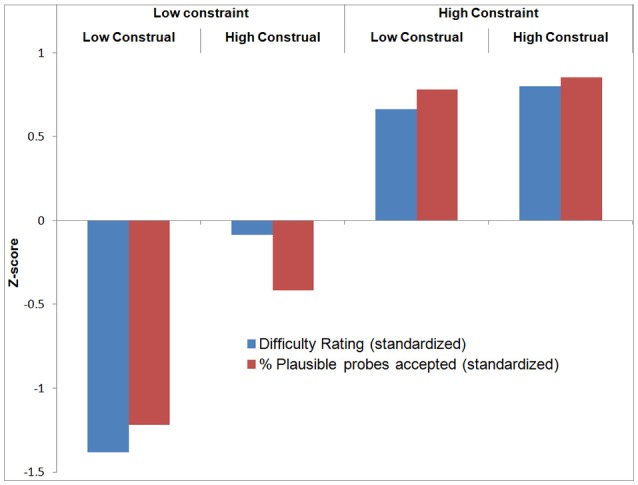
Relationship between difficulty rating and plausible probe acceptance.